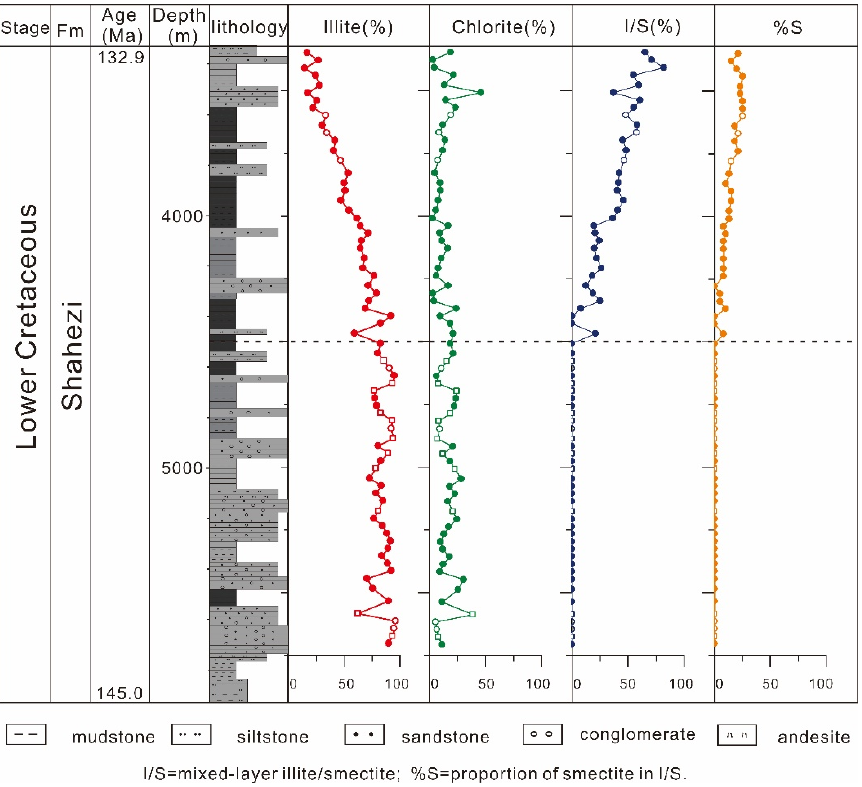
Figure 5. Clay mineral content of Shahezi Formation in SK-2. Solid circles are mudstone samples, hollow circles are sandstone samples, and hollow squares are siltstone samples.